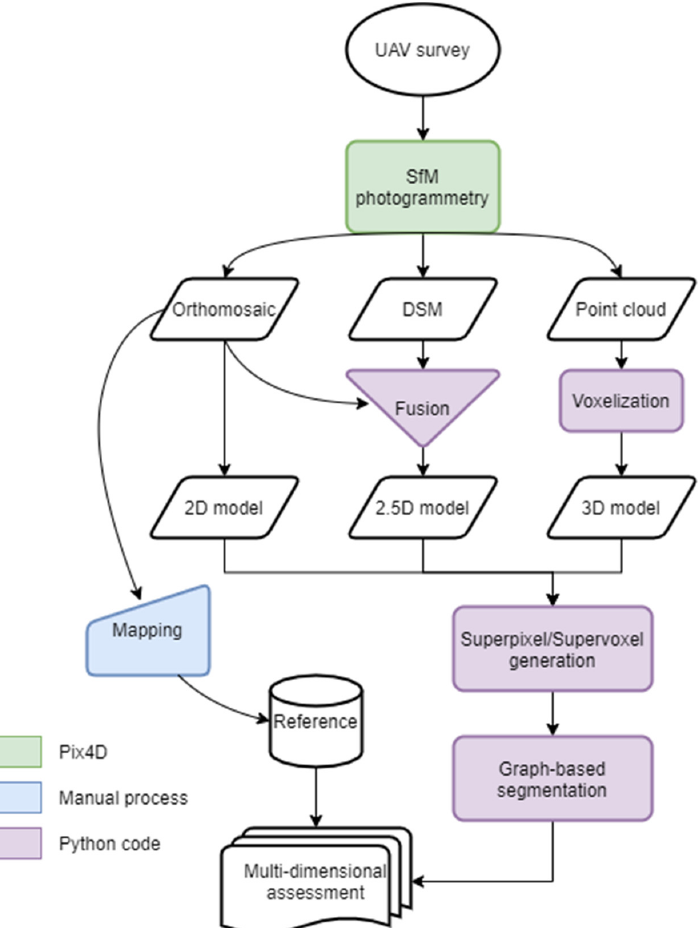
Figure 1. The methodology of the analysis followed for each landslide study site in the current study from raw data capture to segmentation and multi-dimensional assessment of UAV-derived models based on expert-based reference annotations. Each process is coloured by the software/technique used for the implementation while their products are mentioned in white frames.